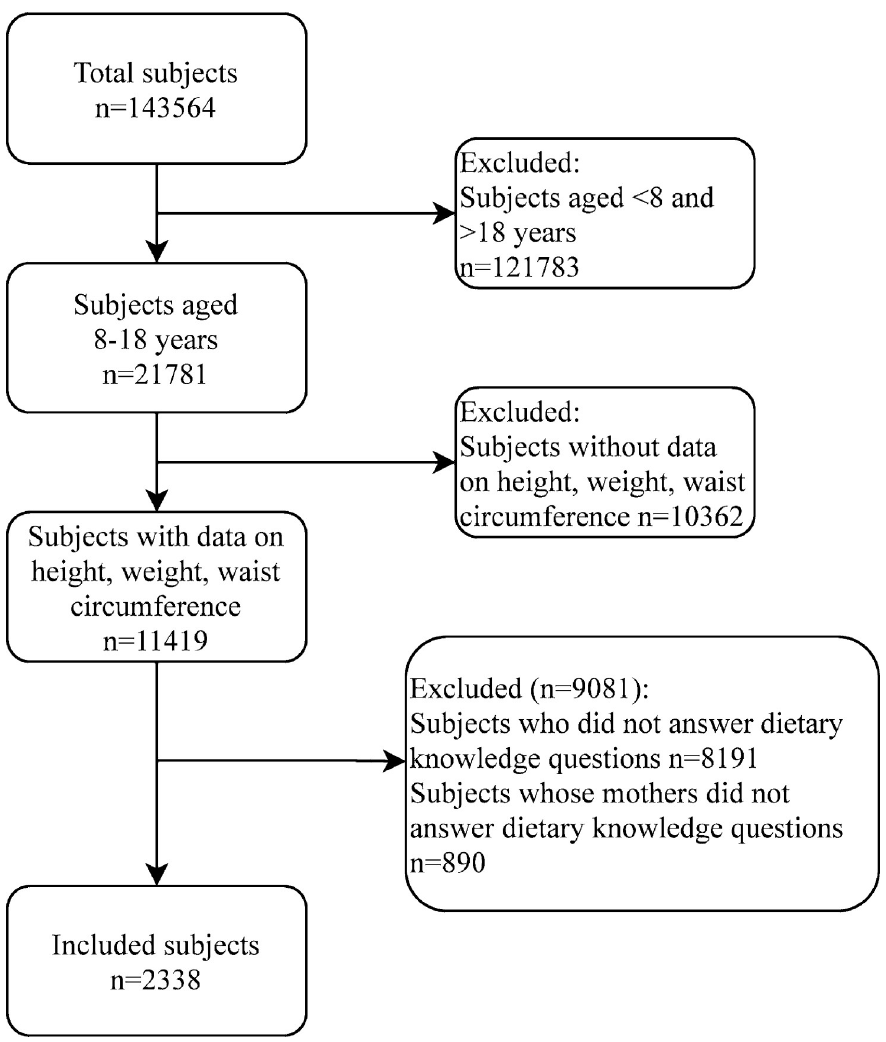
Fig 1. Flow chart of study population